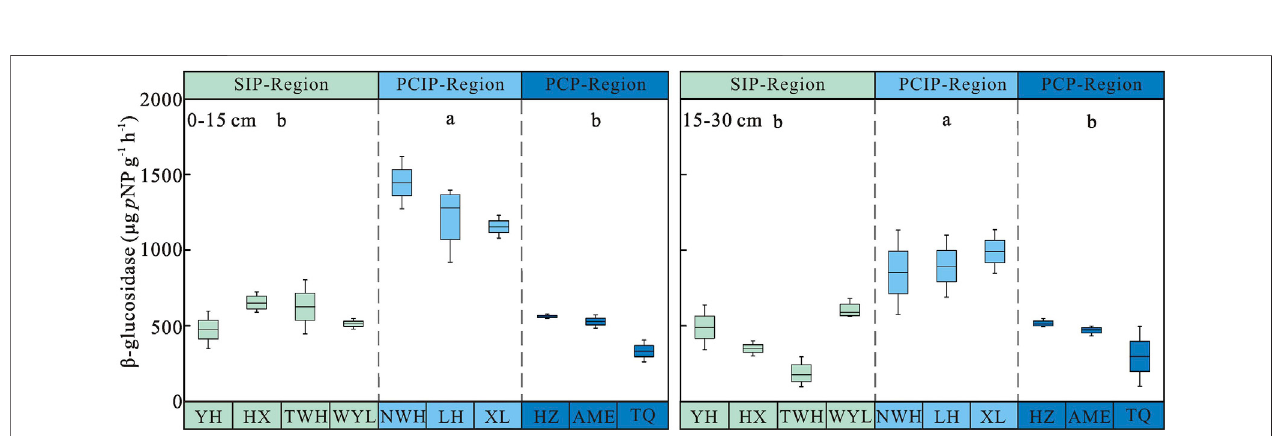
FIGURE 3 | Soil β -glucosidase activity in peatlands from different types of permafrost regions.